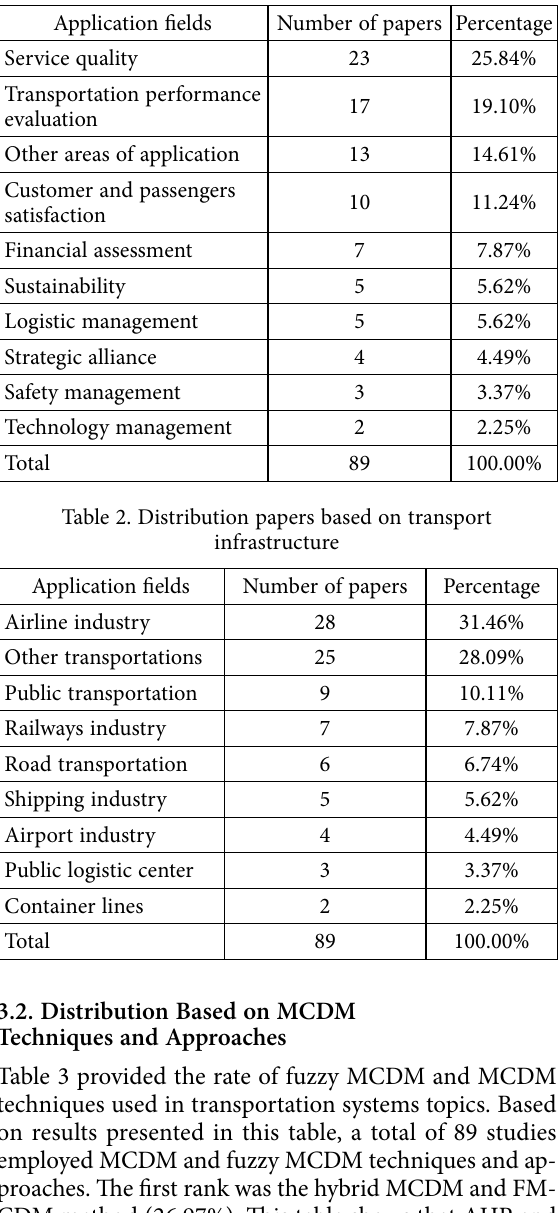
Table 1. Distribution papers based on areas of application